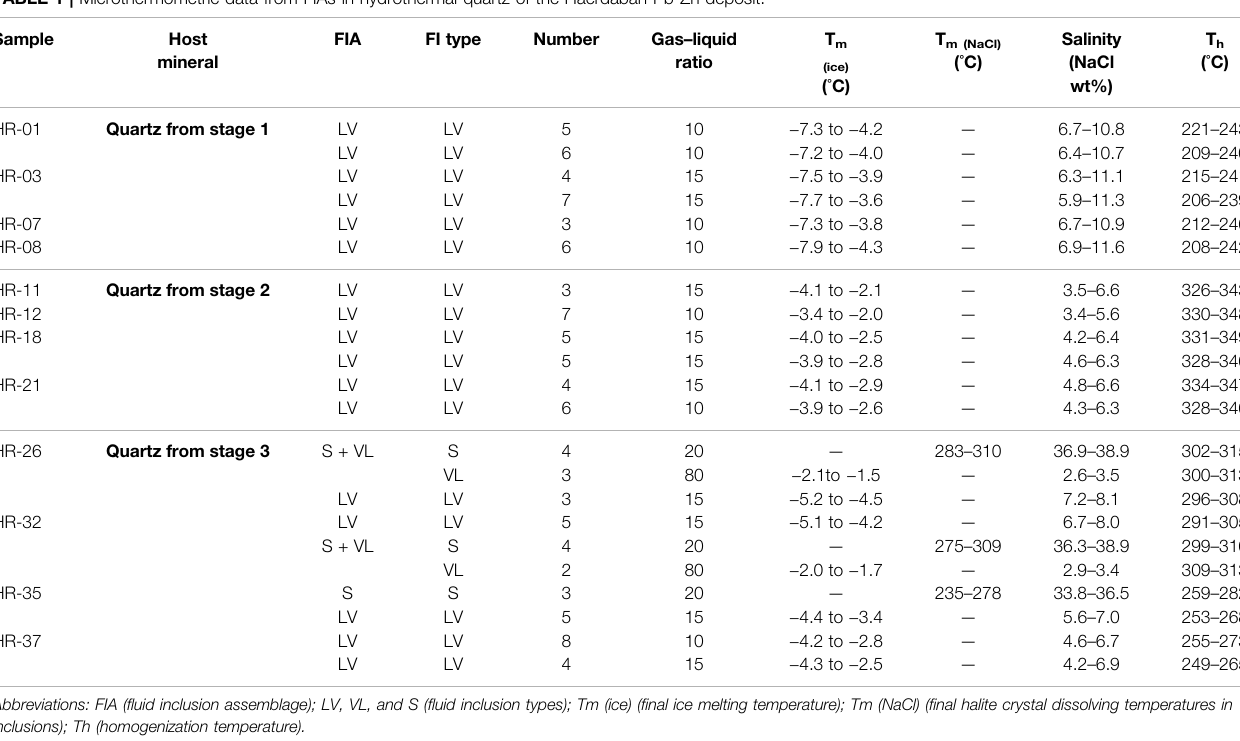
TABLE 1 | Microthermometric data from FIAs in hydrothermal quartz of the Haerdaban Pb-Zn deposit. Sample